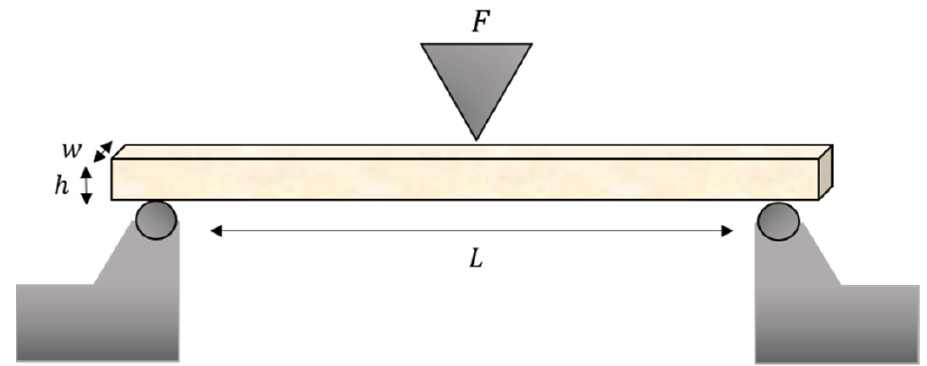
Figure 2. Schematics of the test setup for ISO 10447 flexural strength.